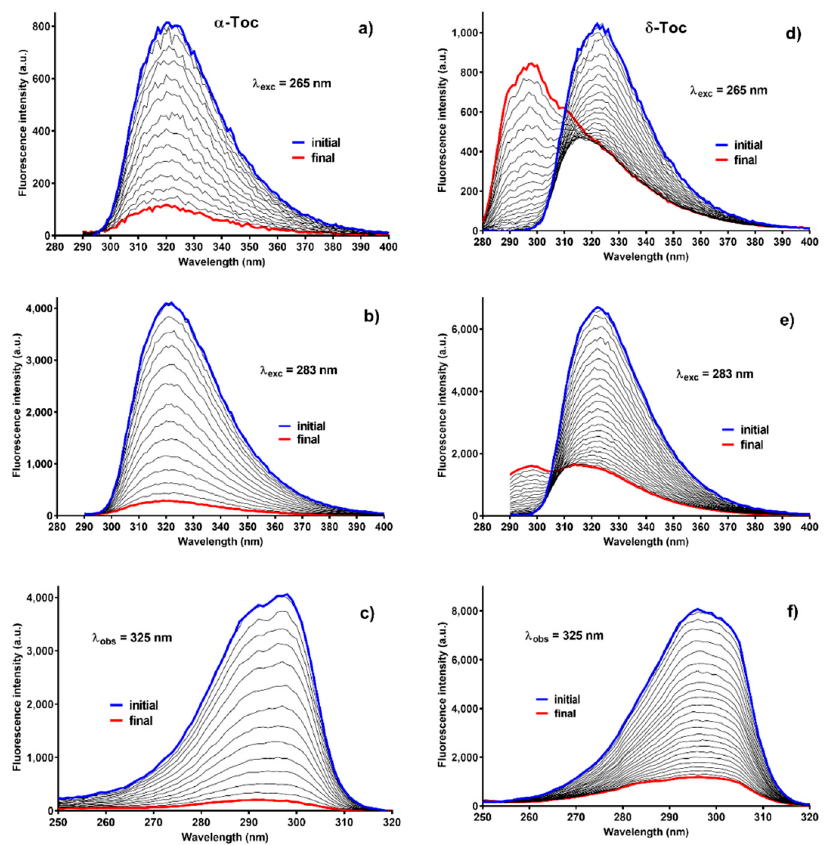
Figure 3. Time-course of Tocs fluorescence spectra: ( a – c )— α -Toc, ( d – f )— δ -Toc. ( a , b , d , e )—emission spectra, ( c , f )—excitation spectra. Irradiation time: α -Toc—409 min, δ -Toc—905 min. λ obs = 325 nm, λ ex = 265 and 283 nm.